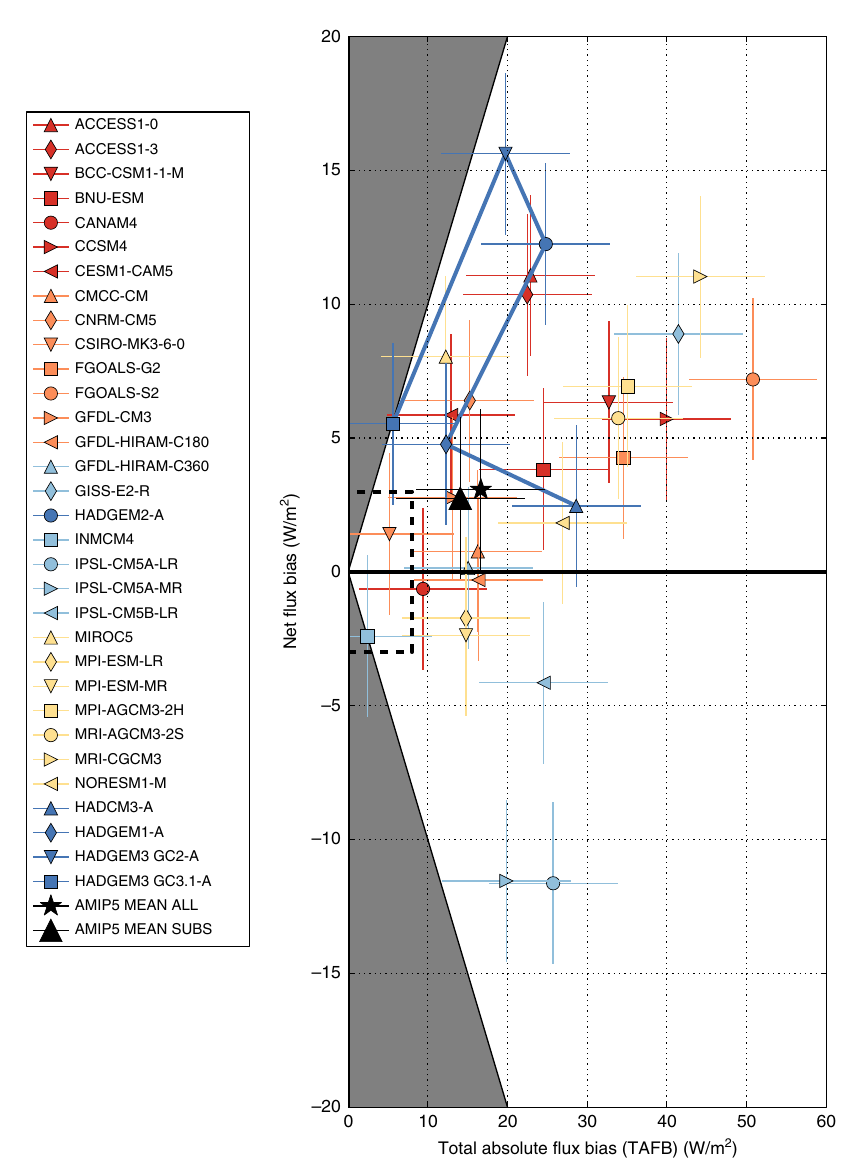
Fig. 5 Relationship between estimated net fl ux biases and estimated total absolute fl ux biases for the AMIP5 and Hadley Centre atmospheric models. Multi-model means for all AMIP5 models (AMIP5 MEAN ALL) and for the subset of 18 AMIP5 models with CMIP5 SST (AMIP5 MEAN SUBS) are also included. The Hadley Centre models are labelled with dark blue symbols and connected in order of release date by a solid dark blue line. Note that these model bias estimates include a contribution from observational errors. Our indicative observational uncertainty estimates of 8 Wm − 2 for TAFB and 3 Wm − 2 for net fl ux (see Methods) are represented by crosses centred on each model symbol. A box enclosing all the model symbols within our estimated observational uncertainties is also marked with a dashed black line. The region where TAFB is less than net fl ux bias is shaded in grey since estimated TAFB must be equal to or larger than estimated net fl ux